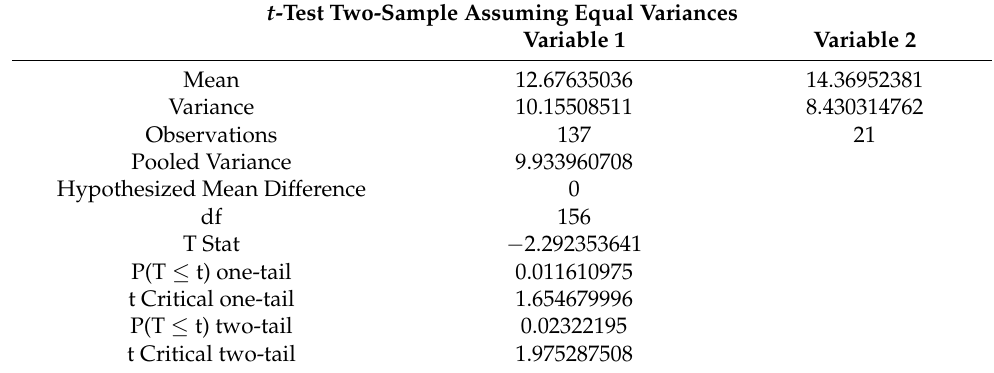
Table 4. State comparison t -Test results. t -Test Two-Sample Assuming Equal